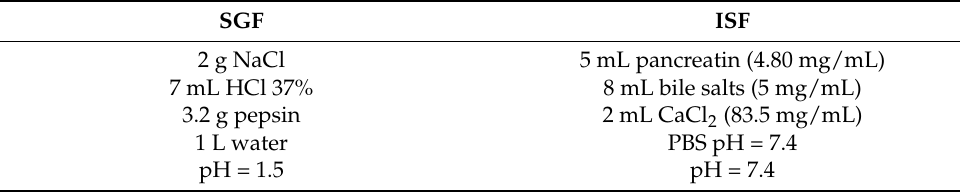
Table 1. Composition of SGF and ISF used for the stability